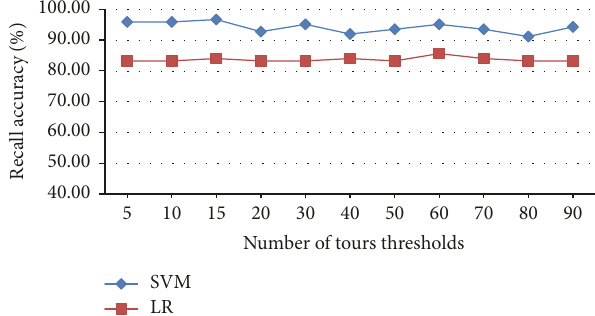
Figure 5: Sensitivity study of prediction accuracy and number of tours threshold for a fixed sample